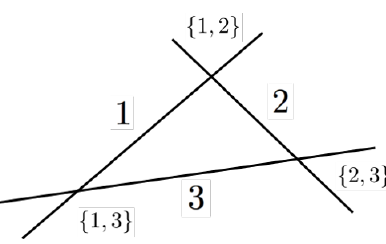
g 1 (cid:20) i (cid:20) 3 in CP 2 . The i